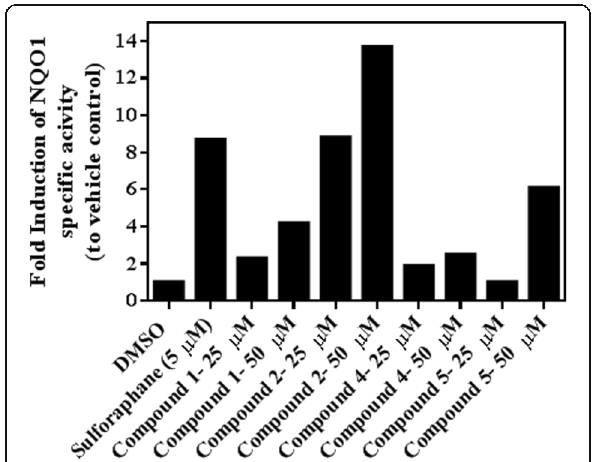
Fig. 2 Fold induction of NQO1 activity by isolated compounds 1 , 2 , 4 and 5 .Hepa-1c1c7 were treated with either vehicle (DMSO) or indicated concentrations of the compounds for 48 h and then cell lysates were assayed for NQO1 activity as described in the Materials and Methods